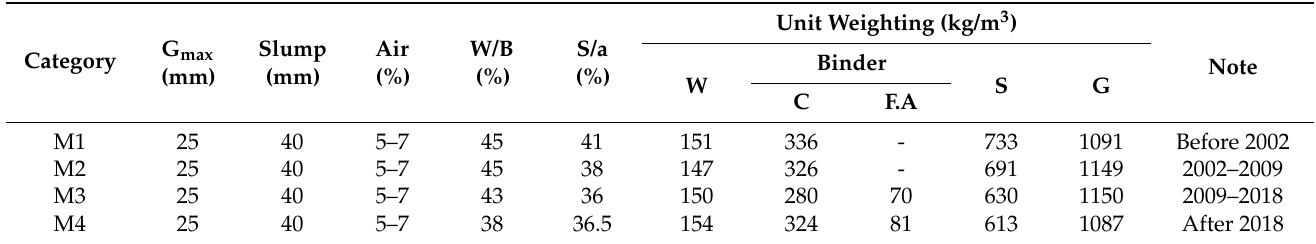
Table 2. Information of core specimens of the concrete pavement slab.